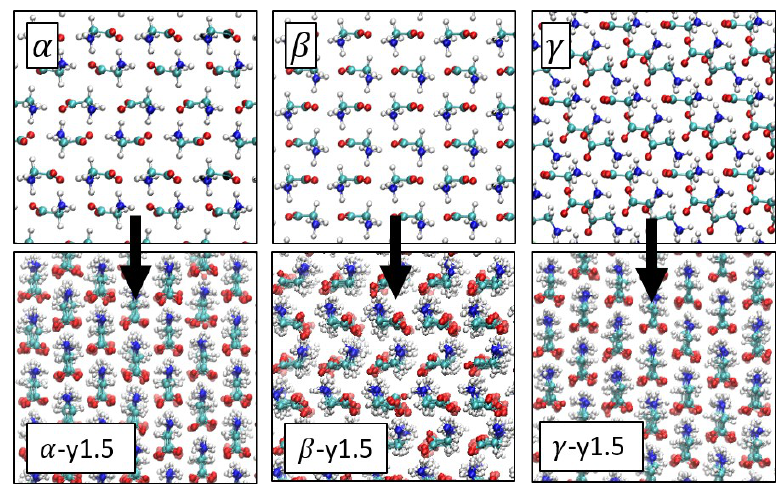
Figure 7. Snapshots of the crystal structures of α -, β -, and γ -glycine crystals before and after the e-field is applied in the y-direction with a strength of 1.5 V/nm. The snapshots are taken after the 125 ns long stability simulations started after the e-field is turned off.